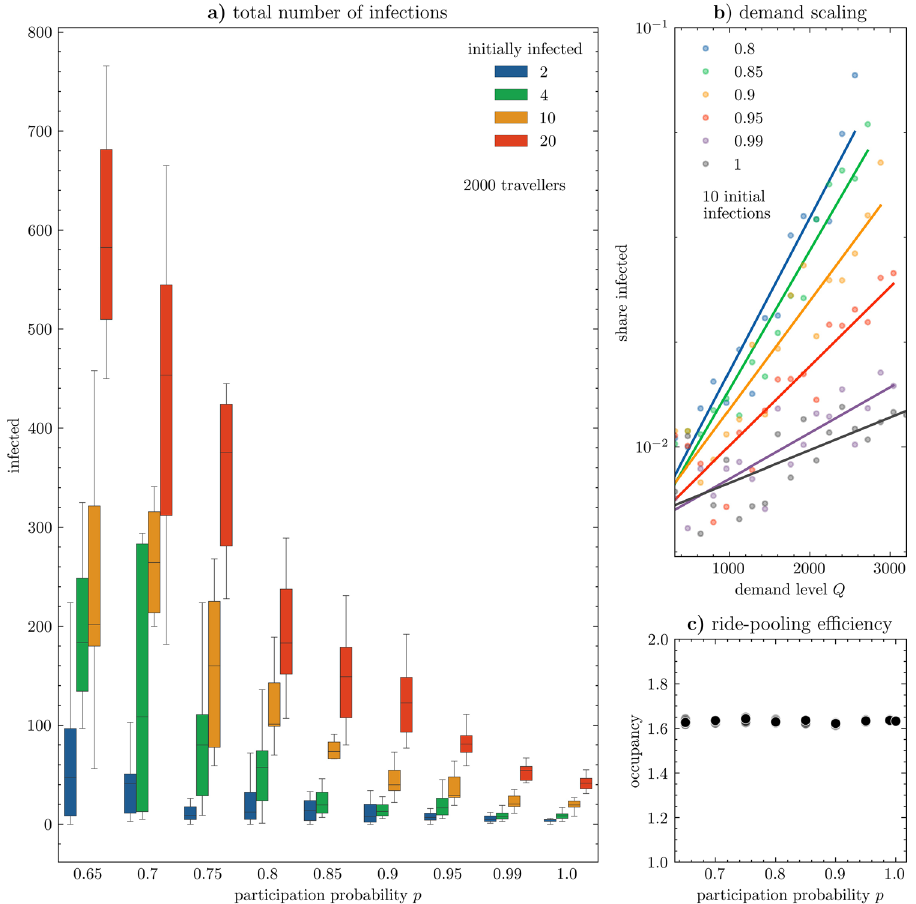
Figure 4. ( a ) Number of eventually infected travellers for varying demand stability p and initially infected travellers. Distributions based on 20 replications (mean within interquantile box and whiskers from min to max values). Initially infected 20 travellers may spread the virus to almost 40% of the population (800 out of 2000 travellers). Yet as long as demand becomes stabilised, outbreaks start being contained. Even a large number of initially infected does not reach more than 10% of the population if demand stability is set to 90% and is eventually contained below 60 travellers (3%) for fully stable demand. The variability of outbreaks also decreases as the demand stabilises: 10 initial infections may reach between 40 and 100 travellers if p = 0.9 , while the range expands from 50 to over 400 for p = 0.7 . The lower bound increases when the number of initially infected is high, making outbreaks more predictable, unlike the ones starting from a small number of infections, for which variability is greater. Importantly, stabilizing the demand does not reduce the efficiency, as we report in (c) , where the mean occupancy (key efficiency indicator of ride-pooling) remains stable as demand stabilizes. Notably, the importance of demand stabilization increases with the demand level as we demonstrate on panel (b) which shows share of infected travellers changing with a demand for various p ’s. Each dot is the average from 20 replications. For all the values of p share of infected individuals scales with the demand level as A exp (α Q ) , marked as trendlines on (b) , with p-values and R 2 reported in the text. For demand levels below 1500, the virus rarely reaches more than 4% of the travellers. In contrast, when the demand level is 2500, the epidemic may reach up to 10% when p = 0.8 or be contained below 2% for a stable demand ( p > 0.9 ), which underlines the importance of control measures for higher demand